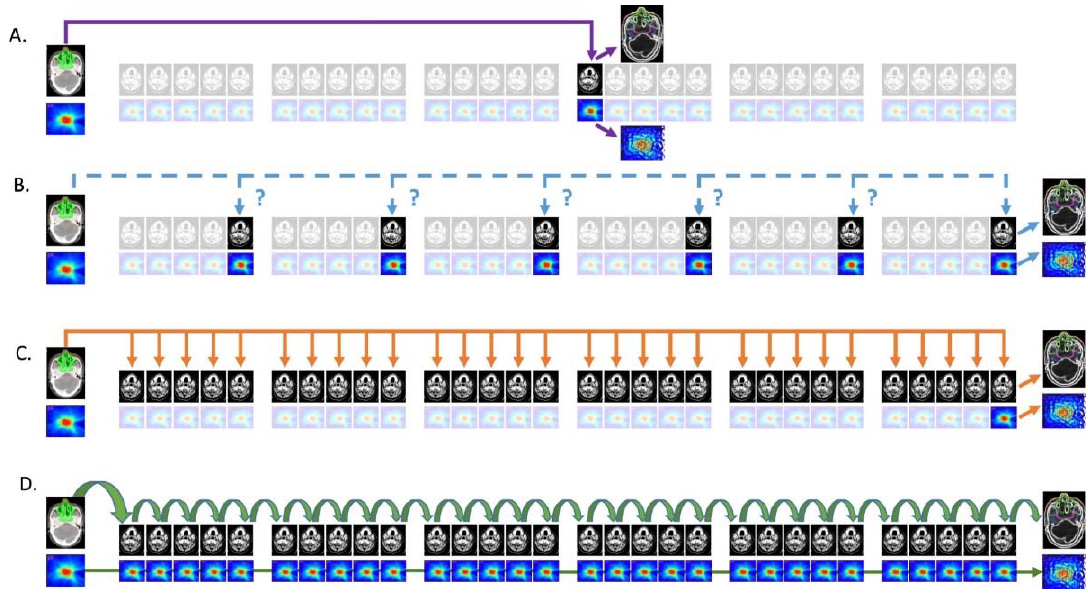
Figure 2. Typologies of ART implementation. ( A ): fixed interval approach; ( B ): ‘triggered’ ART; ( C ): serial ART; ( D ): cascade ART. Figure and copyright permissions obtained from Heukelom and Fuller [37].